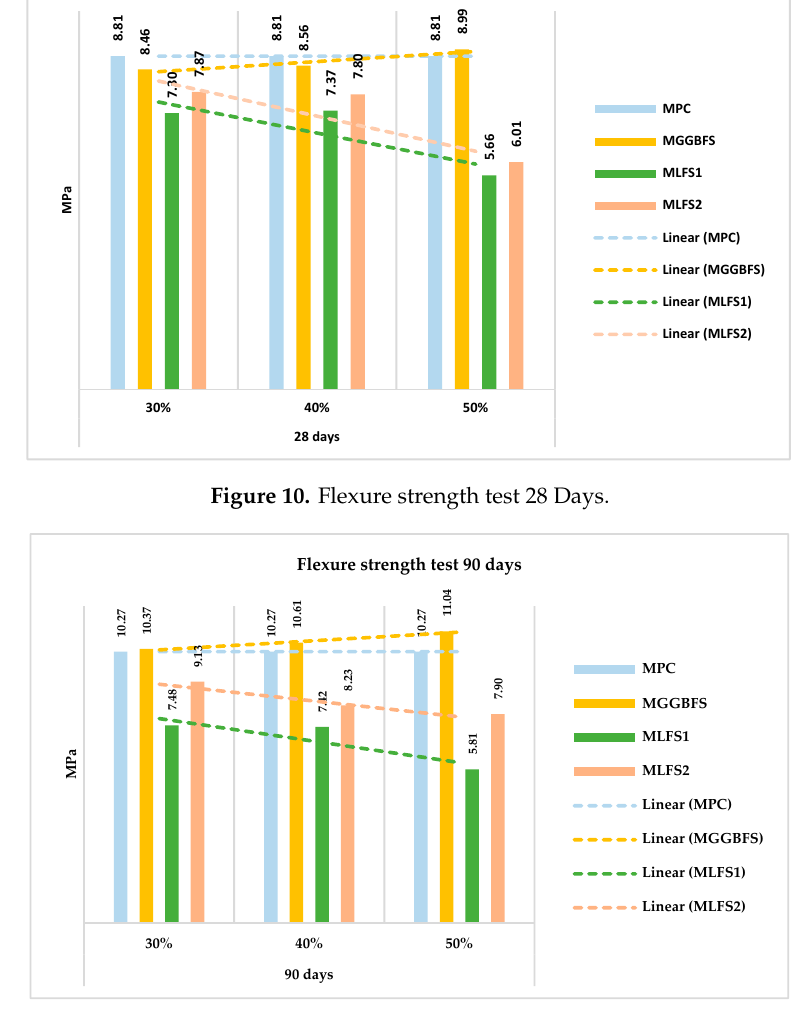
Figure 12. Percentage increased and decreased flexure strength. 4.5. Comparison between 90-Day Flexure and Compressive Strength The significance of this study is highlighted in the comparison of the gain or loss of the strength against flexure and compression combined. We will focus on that point in this section. In Figure 13, the comparison in percentage of the strength, both compressive and flexural, in each of the mixtures made, highlights that the losses of flexural strength of the mixtures with slag LFS are much lower than those of compressive strength. This decrease in strength is practically half in most cases. In the strength of the mixtures with GGBFS does not increase twice as much in the flexural strength, as would be expected by the previous results, but only half. Apart from substitutions of 50%, this percentage of 4% is maintained. This indicates the feasibility of LFS slag in non-structural elements, valuing a waste as a by- product, reducing the production of cement that generates a large amount of CO 2 into the environment.